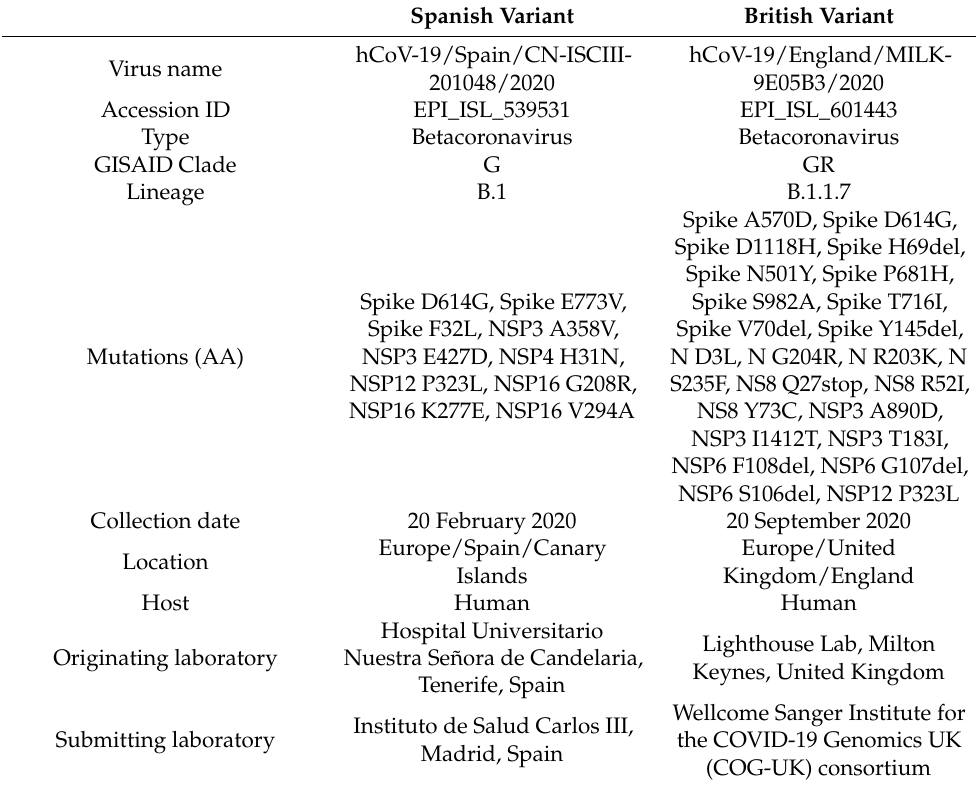
Table 1. Details of the two SARS-CoV-2